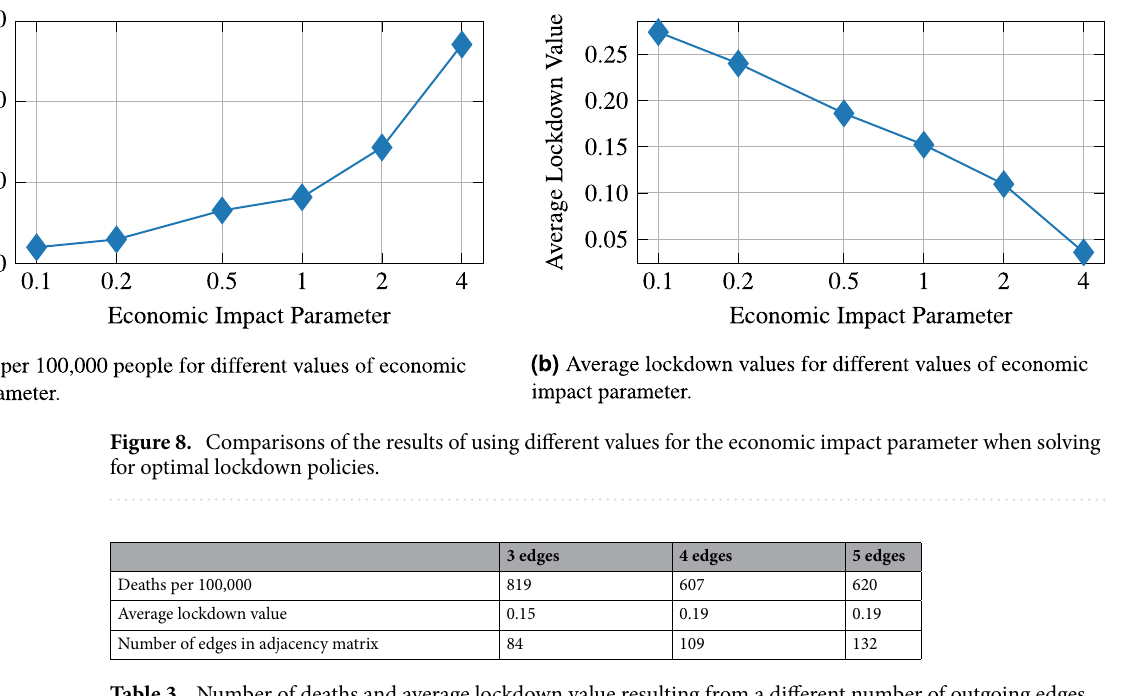
Table 3. Number of deaths and average lockdown value resulting from a different number of outgoing edges per subregion in the multiscale SIRD model of the Phoenix MSA. By using a model incorporating more edges, we can reduce the deaths by up to 26%, without inducing a significant increase in the average lockdown value.